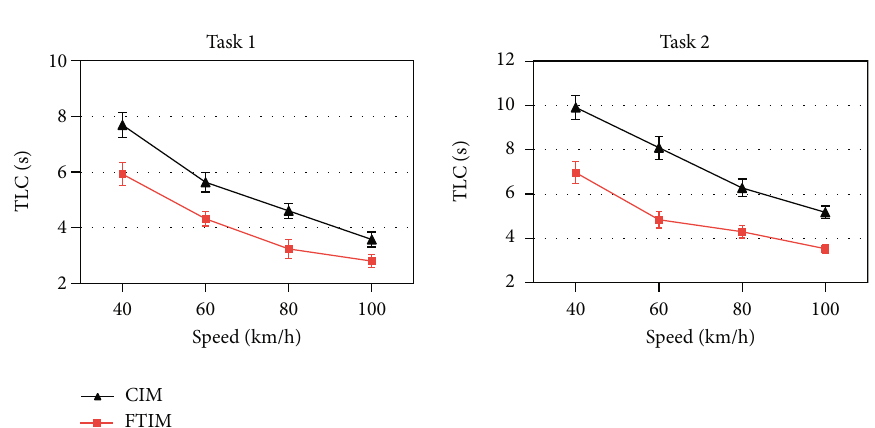
Figure 13: The interaction between interaction mode and speed in